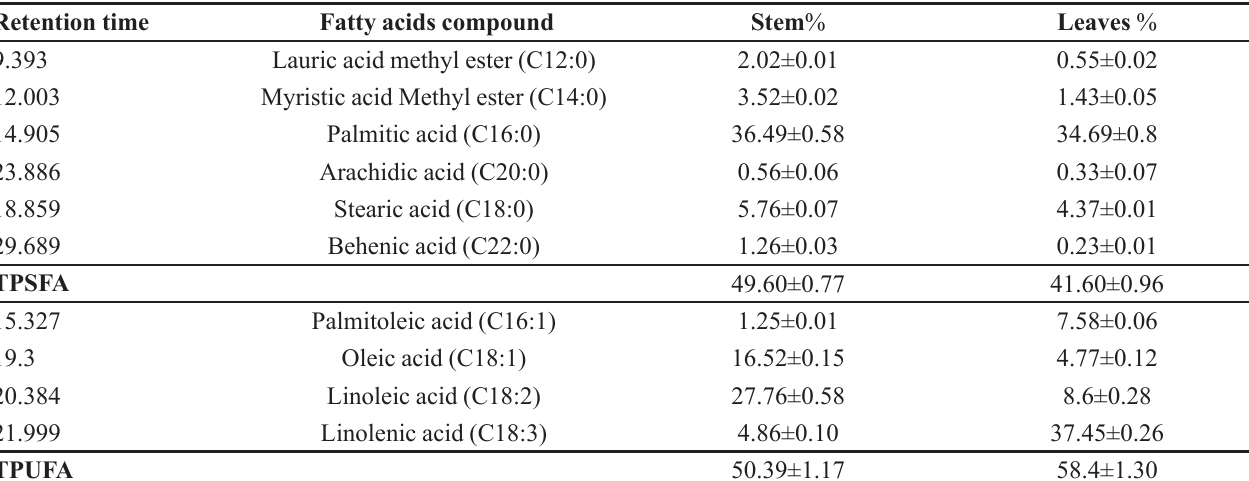
TABLE II - Fatty acid content of leaves and stem bark of A. laurina Retention